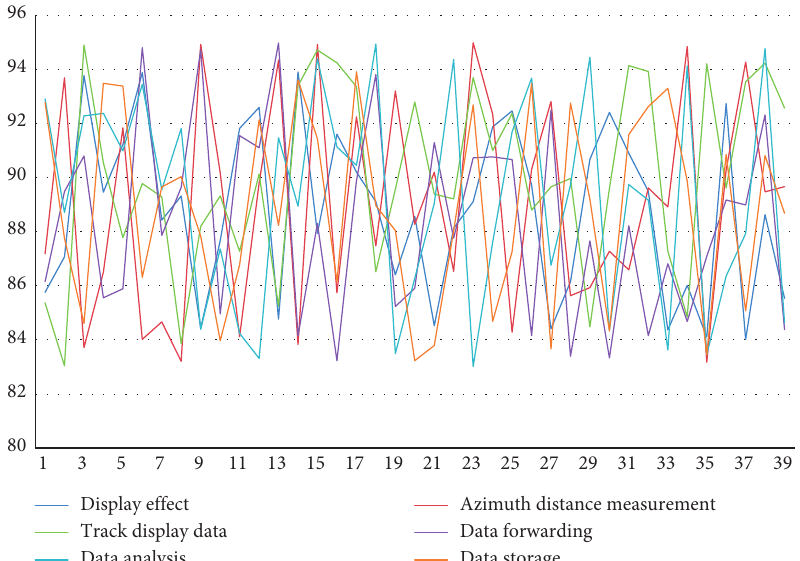
Figure 14: Statistical diagram of the score of the data processing effect of the channel optimization system of the ABS-B aviation target surveillance radar based on the improved filtering algorithm.